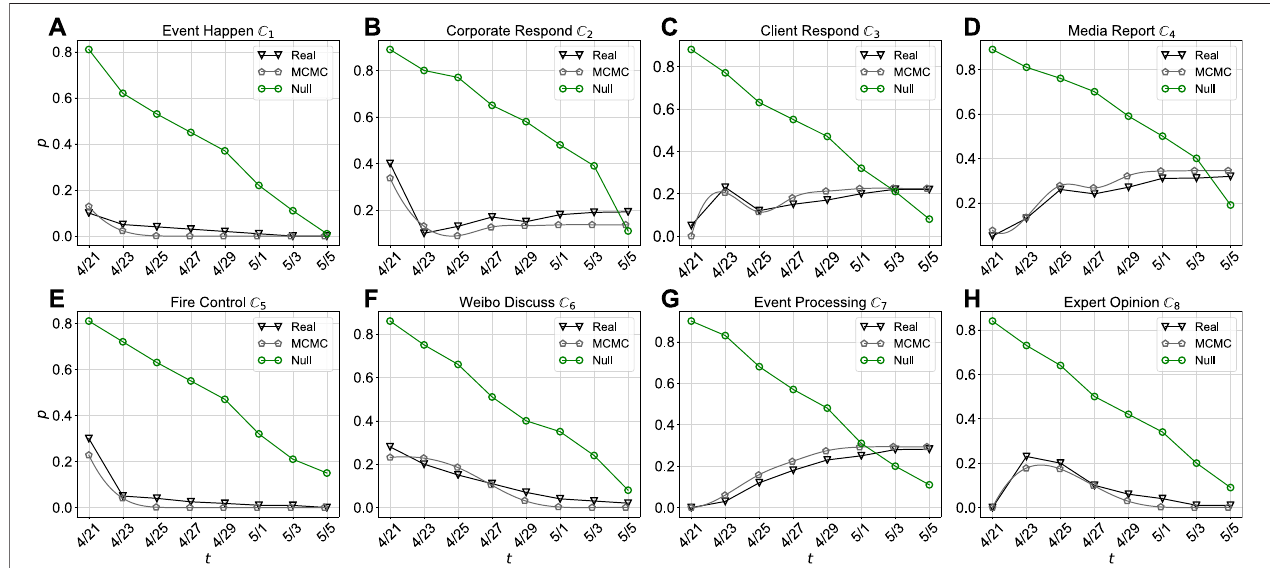
FIGURE4| Popularitycurveofsub-eventdevelopment.Threecurvesaretherealpopularitydynamic,thepopularityofunfoldingmodelregeneratedbyMCMC,and the reference popularity of null model. The evaluations are between the three curves by JSD . For example in (A) , the JSD value between real and MCMC popularity is 0.095, which shows the close trends between unfolding model and real dynamic. The JSD value between MCMC and null popularity is 0.7329, indicating the signi fi cant difference between the unfolding model and the random model. The rest of JSD values (B – H) can be seen in Table 3.